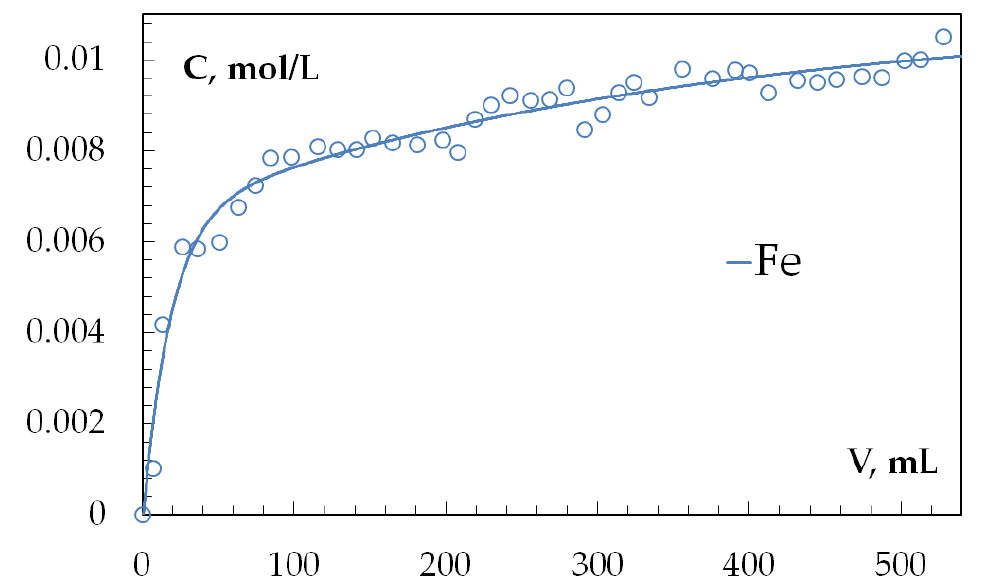
To study the sorption process under dynamic conditions, a sample weight of 2.0010 ± 0.0002 g of organic material with a fraction of >1 mm, and model solutions with a pH value of 1.7–1.9 and a metal concentration of 0.01–0.1 mol/L, were used. The experimental results are presented in Figures 8–10.